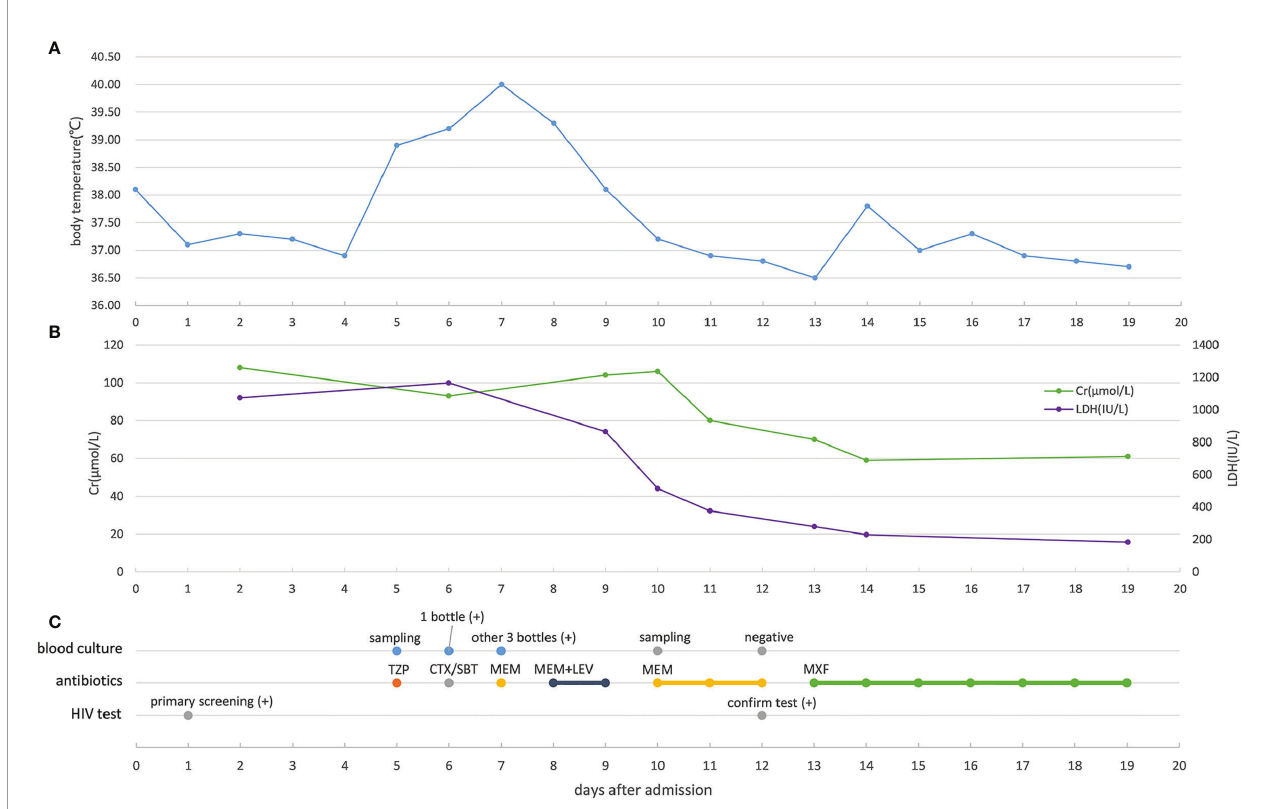
FIGURE 2 | Changes in key indicators related to severity and anti-infection treatment (A) Changes of the patient ’ s body temperature during hospitalization. (B) Changes of creatinine and lactate dehydrogenase in the patient ’ s peripheral blood during hospitalization. (C) Blood culture result, antibiotic treatment, and HIV test result of the patient. Cr, creatinine; LDH,actate dehydrogenase; TZP, piperacillin/tazobactam; CTX/SBT, cefotaxime/sulbactam; MEM, meropenem; LEV, levo fl oxacin; MXF, moxi fl